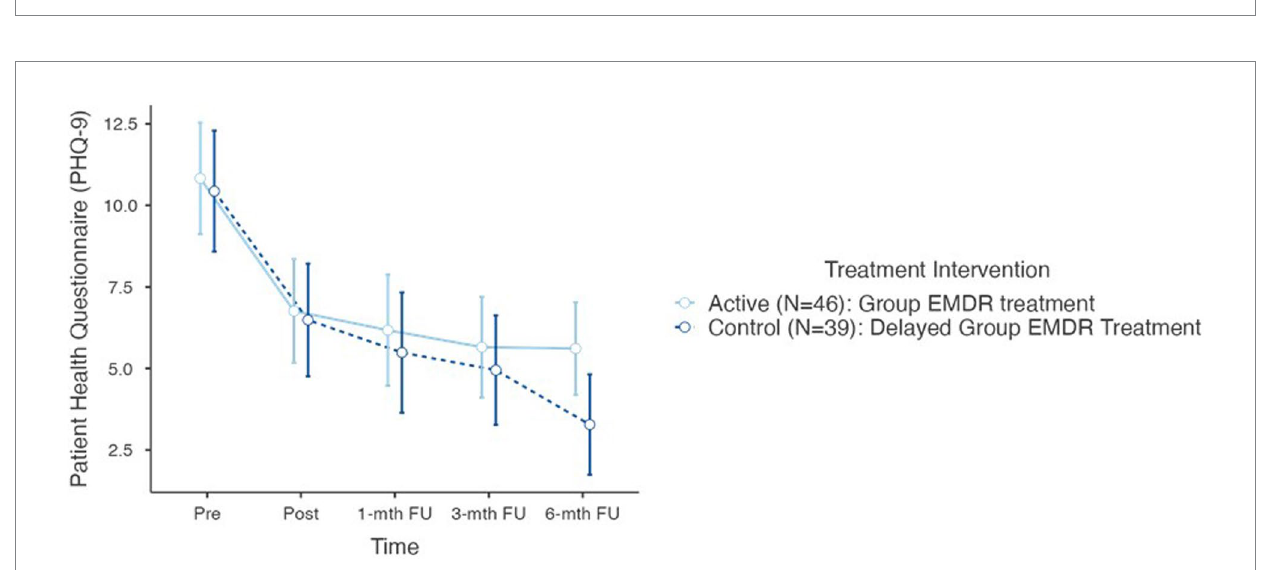
FIGURE 7 PHQ-9 psychometric scores for active and control groups (total N